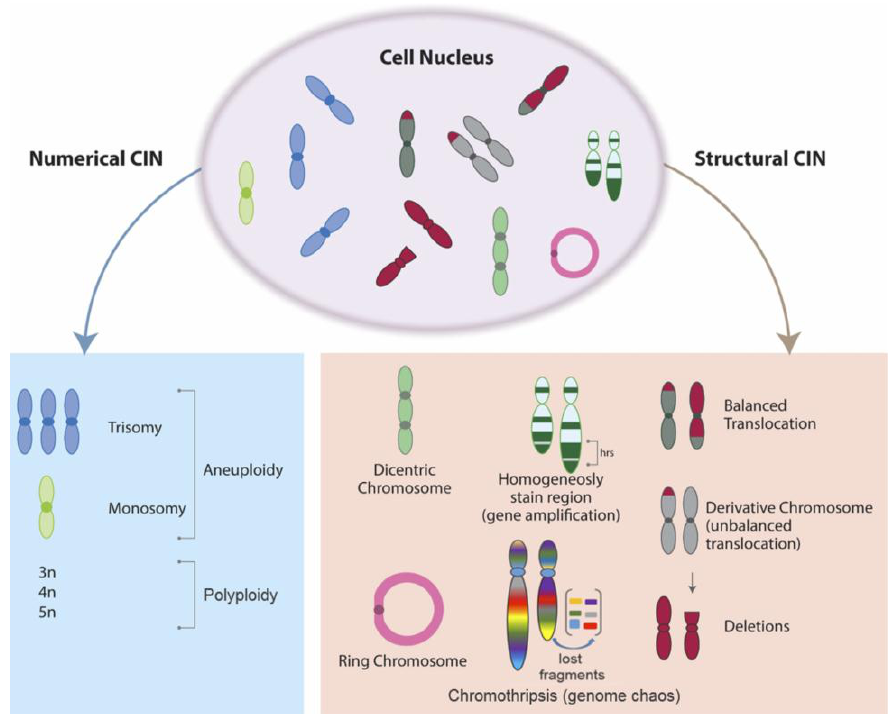
Figure 1. Chromosomal instability (CIN) Characteristics. CIN is characterized by aberrant distribution of chromosomes to the daughter cells deviating from the modal number (numerical CIN—aneuploidy and euploidy) or an elevated frequency of structural chromosome aberrations such as gain or loss of partial chromosomes ( structural CIN ) .